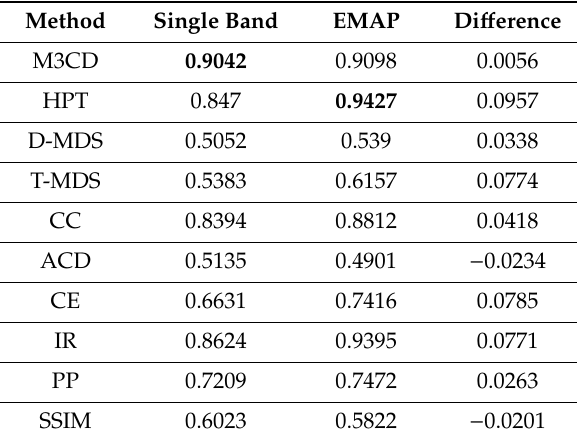
Table 4. AUC values and di ff erences between single band and EMAP cases for dataset-3. Bold numbers indicate the best performing method in each column.